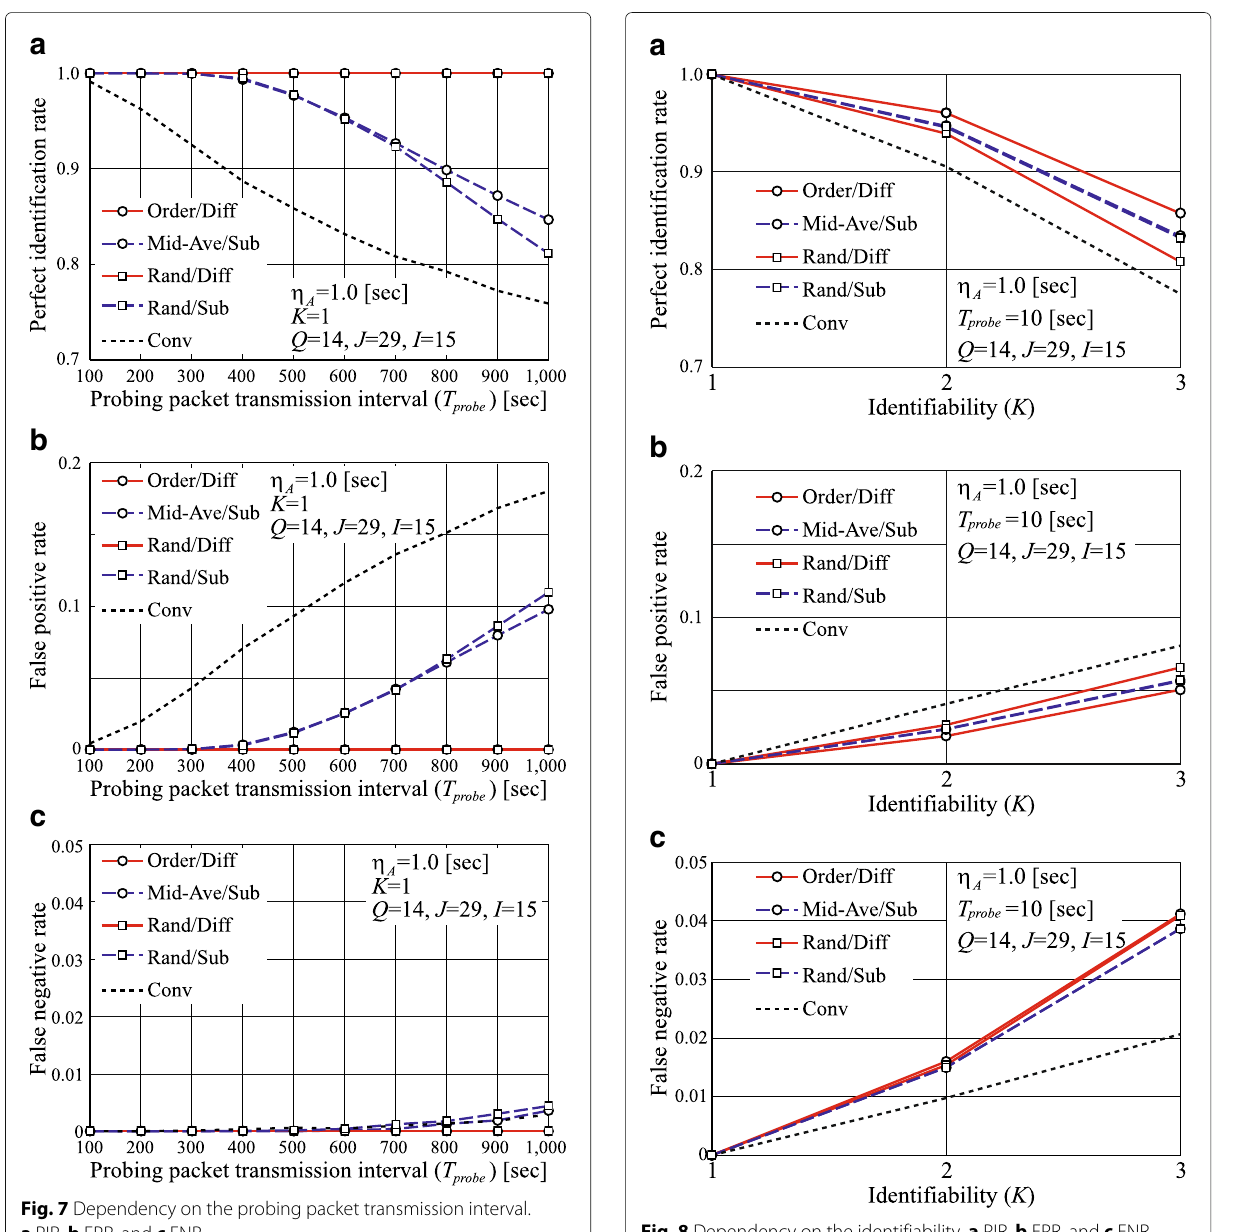
Fig. 8 Dependency on the identifiability. a PIR, b FPR, and c FNR